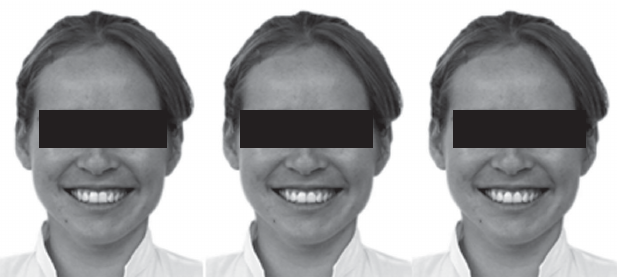
Fig. 1 - Female square facial contour set. Each photograph presents a different shape of upper central incisors.